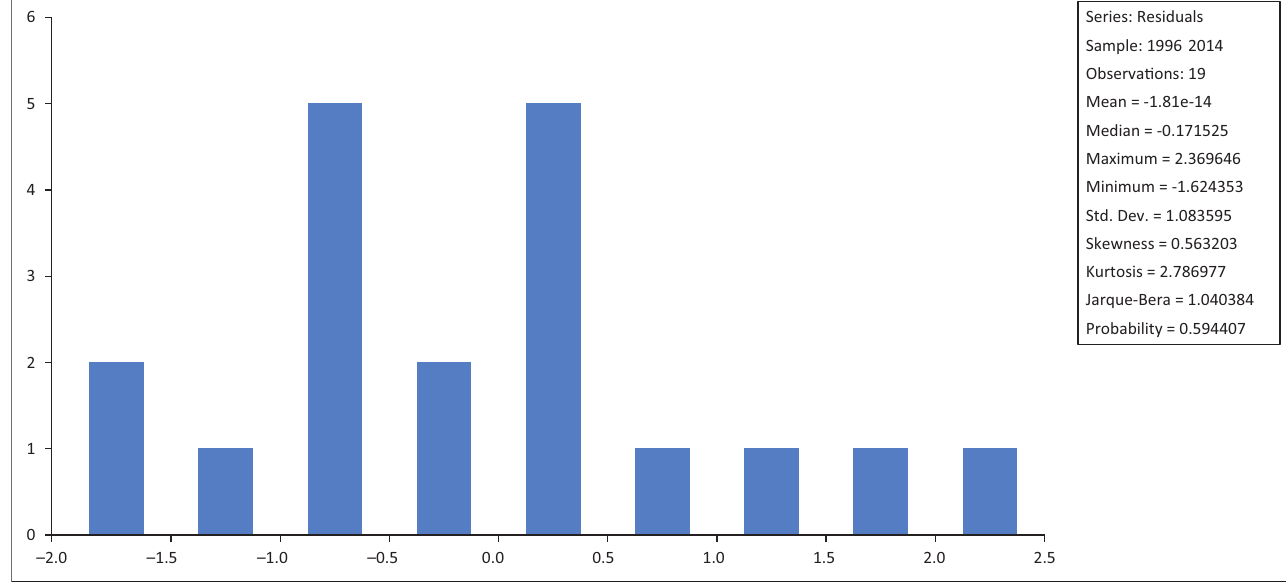
FIGURE 1-A1: Jarque–Bera normality test.